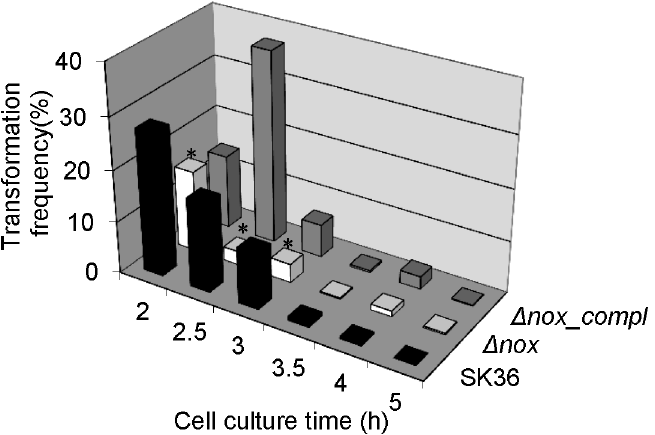
difference with P < 0.05 compared to SK36. Data obtained at least in